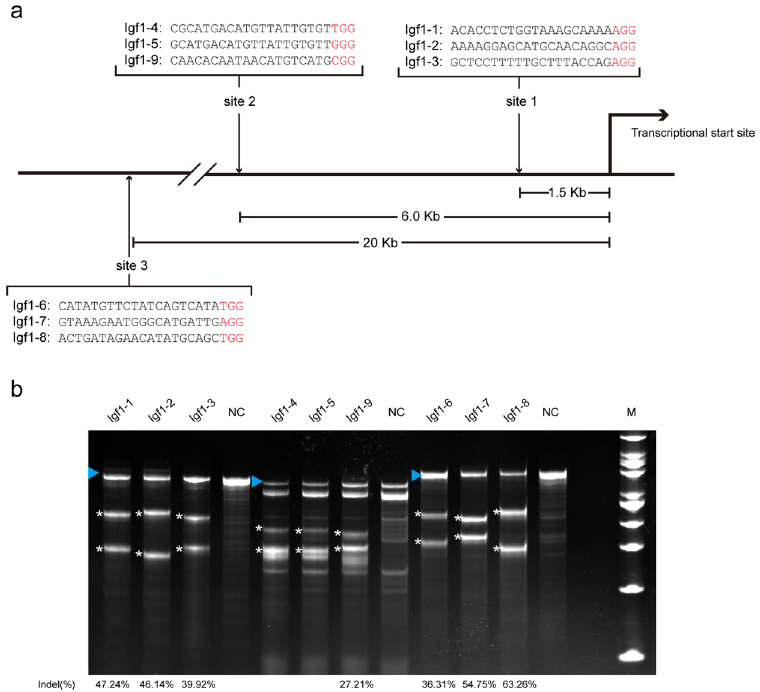
Figure 2. Evaluation of sgRNAs targeting the three candidate insertion sites. (a) Schematic of the sgRNAs targeting the three candidate insertion sites. The protospacer-adjacent motifs (PAM) are labelled in red. The distance between each candidate insertion site and the transcriptional start site is shown. (b) T7EN1 assay detection of the efficiency of Cas9-mediated cleavage at the indicated targets. The blue triangles indicate the locations of the PCR products before T7EN1 digestion. The asterisks indicate cleaved PCR amplicon fragments of the expected sizes after T7EN1 digestion. The extra blots in lanes of the sgRNAs targeting the site 2 have no relation to the gene editing events and may arise from the SNPs existing in the C2C12 genome. The sgRNAs Igf1–1, Igf1–9 and Igf1–7 were used to generate double-stranded breaks to stimulate homologous recombination in each of the three respective candidate sites. NC: WT